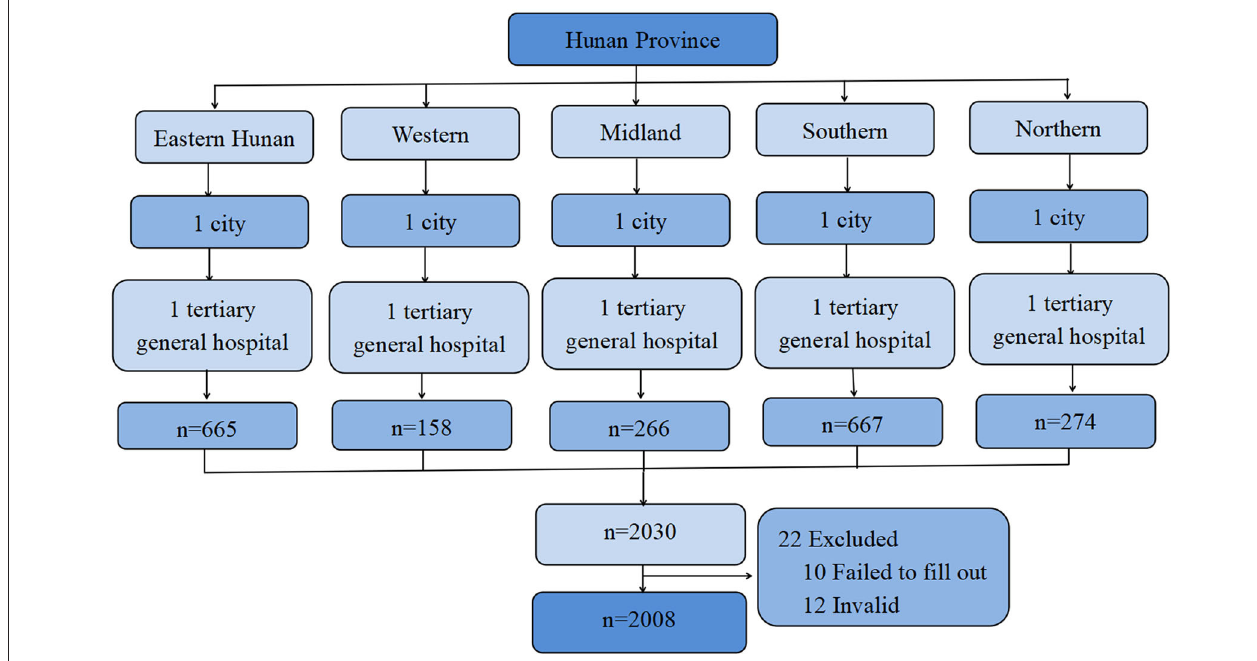
FIGURE 1 | Flowchart of the multi-stage stratified sampling with random